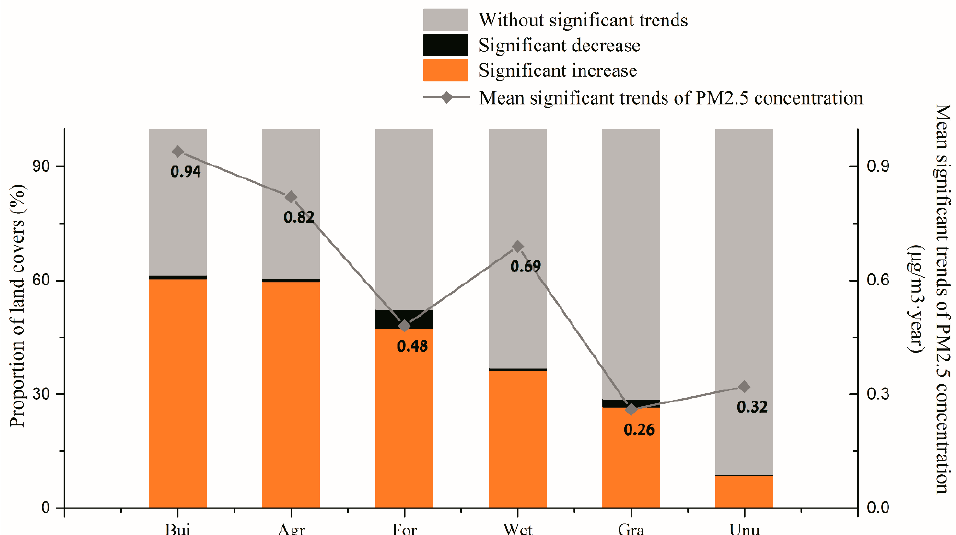
Figure 5. Mean trends of the PM 2.5 concentration and proportion of different land use types.